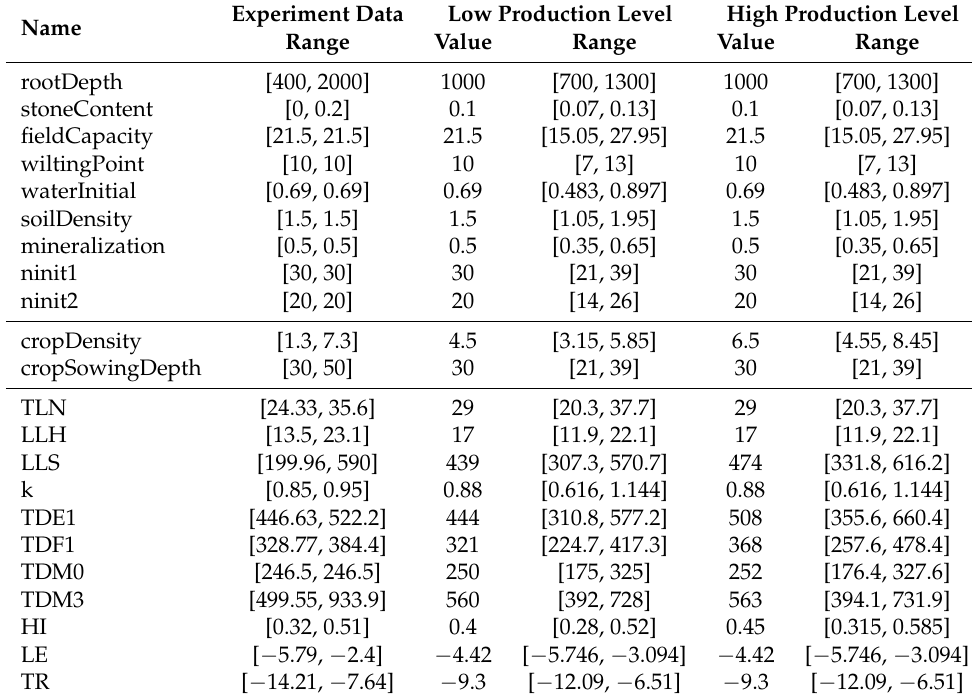
Table 3. Data summary and configuration of the Morris method for two production situations: the low and high level production situations.